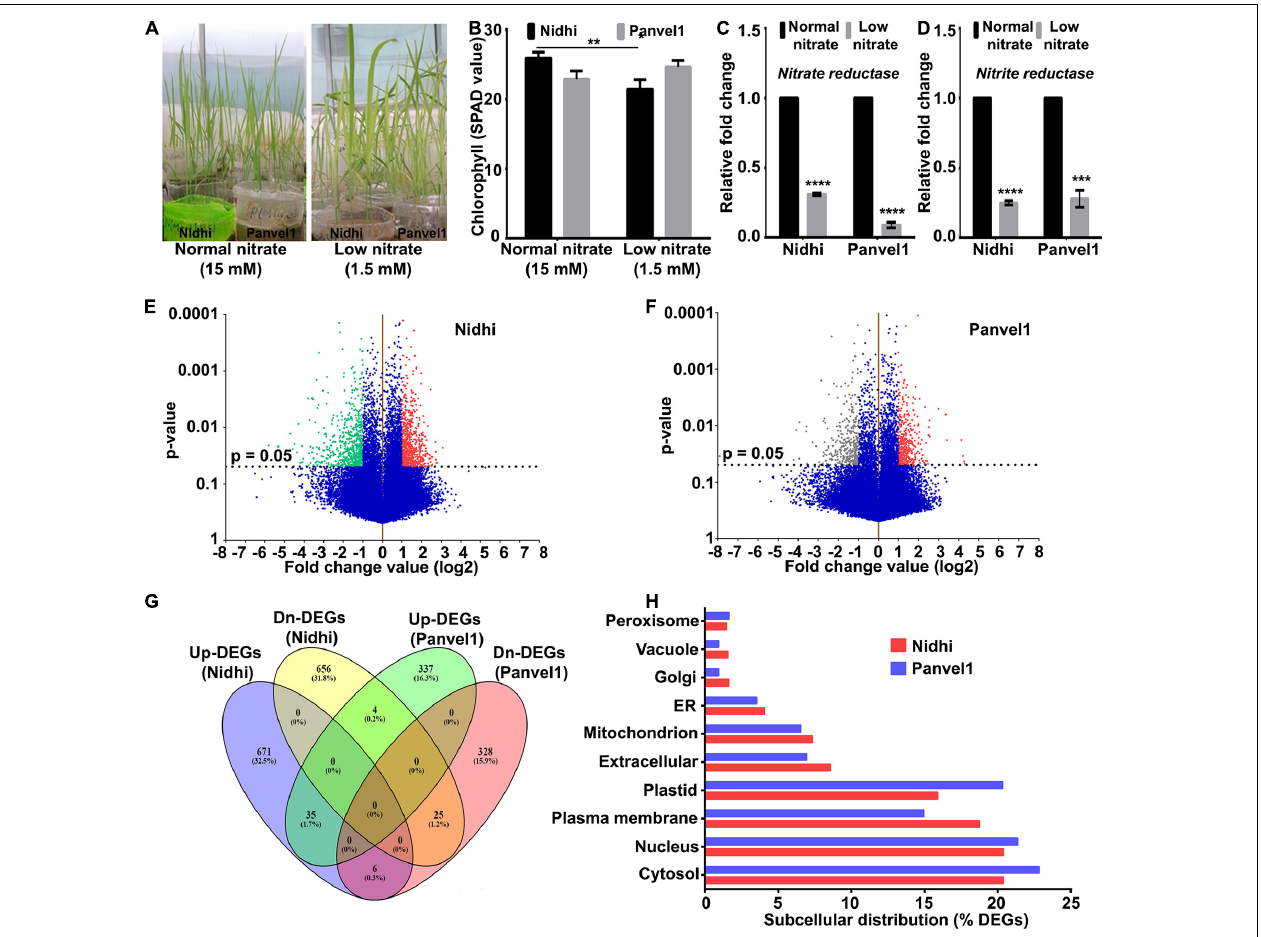
FIGURE 1 | Nitrate-responsive transcriptomes in Nidhi and Panvel1. (A) Representative image of 21 days old Nidhi and Panvel1 plants grown in nutrient-depleted soil supplemented with AH media containing normal (15 mM) and low (1.5 mM) nitrate. (B) Leaf chlorophyll content (SPAD value) was estimated earlier in Nidhi and Panvel1 (Sharma et al., 2021). Quantitative RT-PCR was used to calculate the relative mRNA expression of nitrate reductase (C) and nitrite reductase (D) genes in 21 days old Nidhi and Panvel1 plants. Test samples were low nitrate, whereas normal nitrate samples were used as control. The actin gene was used as a reference gene to normalize the expression data. Data represent the mean ± SE of three technical replicates. An unpaired t -test was performed in GraphPad Prism. Experiments were performed repeatedly with two independent biological replicates. Volcano plots for differential gene regulation are shown for Nidhi (E) and Panvel1 (F) . Scattered dots represent different transcripts and the horizontal dashed line corresponds to the P -value cut-off ( P = 0.05). Red scattered dots represent the mapping of upregulated genes, whereas downregulated genes are by green dots. (G) Venn diagram shows commonly and uniquely up or downregulated DEGs between Nidhi and Panvel1. (H) Predicted subcellular localization of DEGs encoded proteins in Nidhi and Panvel1. ** P < 0.01, *** P < 0.001, **** P <